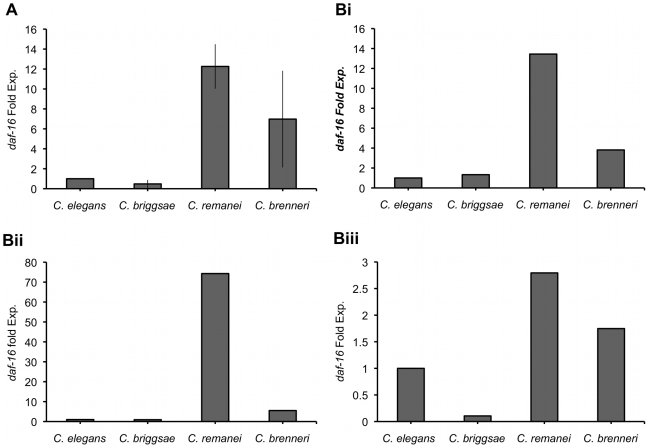
Quantitation of daf-16 gene expression.(a) mRNA from a mixed population of hermaphroditic (N2, AF16) and gonochoristic (EM464, CB5161) animals was extracted and daf-16 gene expression was quantified relative to the housekeeping gene gpd-3. Data represent the mean of three experiments, error bars show standard deviation. (b) daf-16 gene expression for the same species but measured at various stages of development that include L2-L3 stage (bi), L4 stage (bii) and the adult stage (biii).